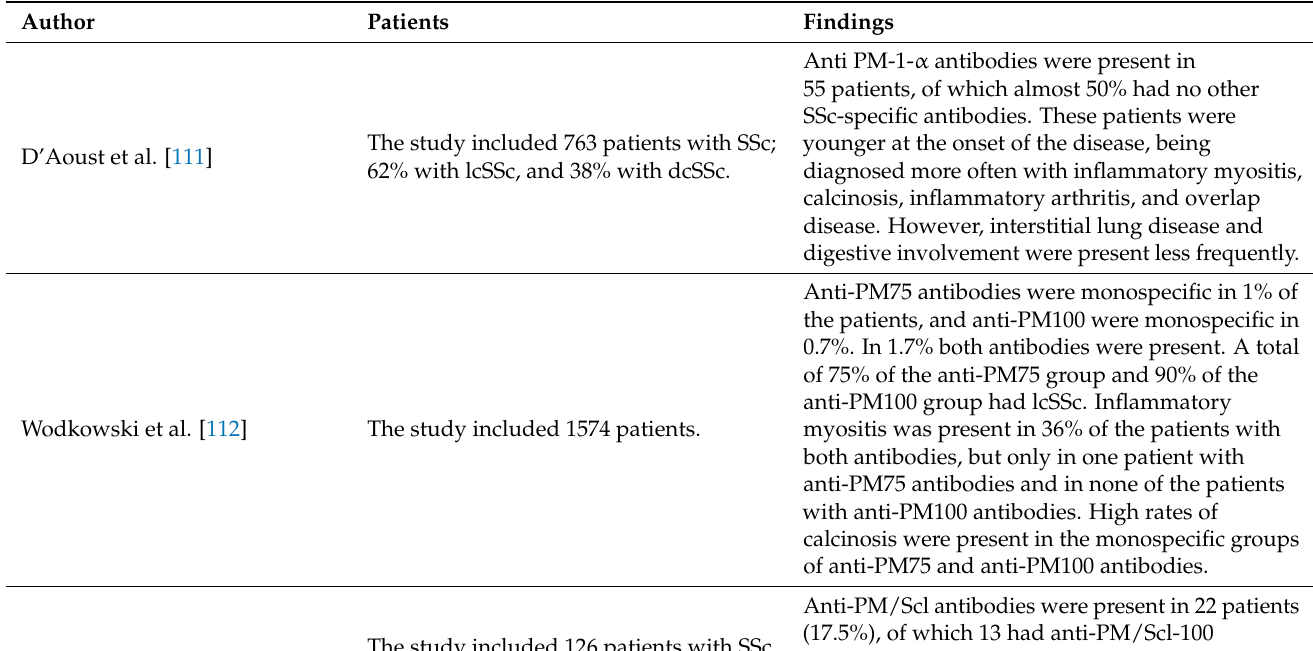
Table 4. Studies that tested the presence of anti-PM/Scl antibodies in SSc